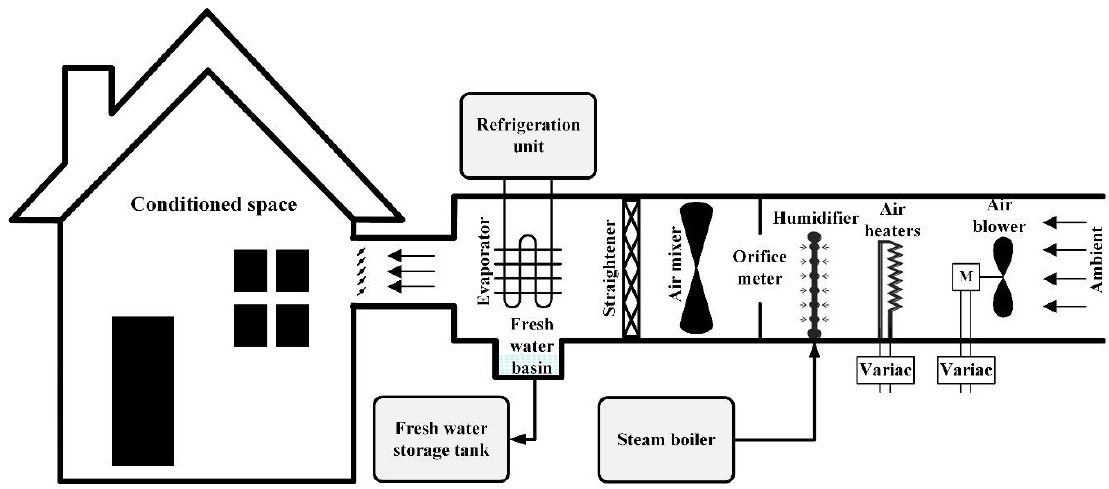
Figure 8. The solar HDH-VC system (adapted from [93]).